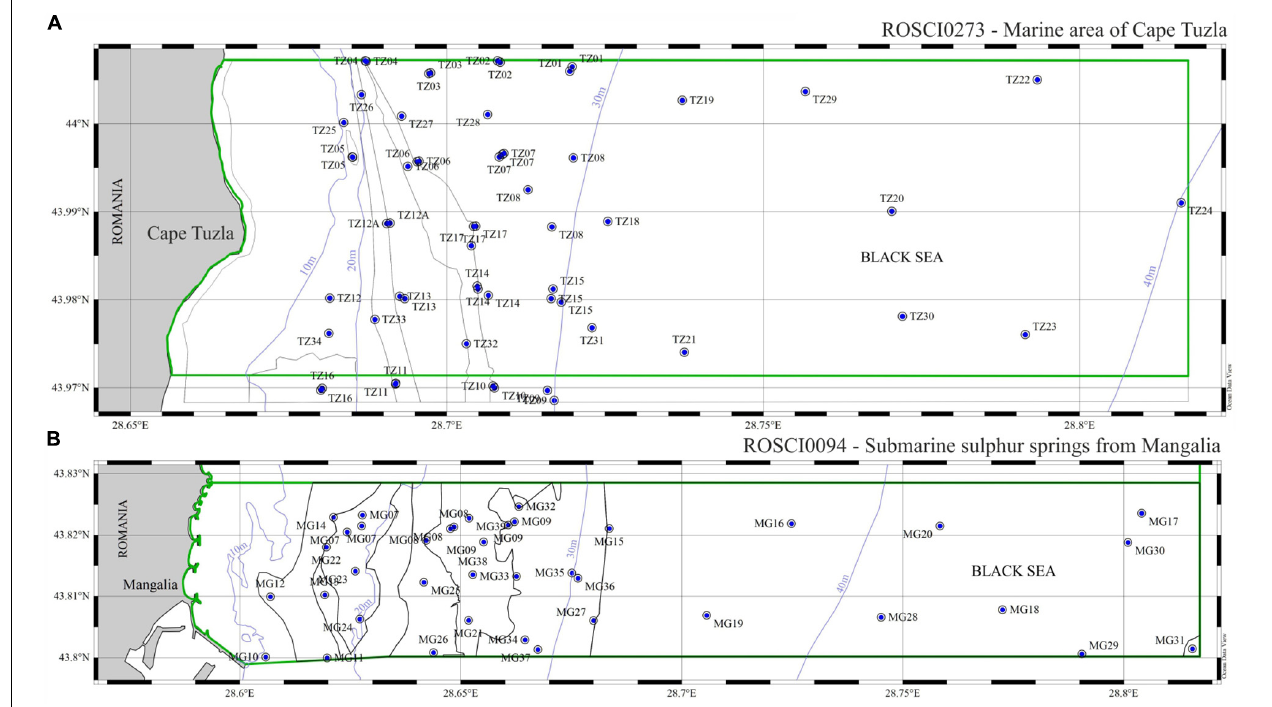
FIGURE 2 | Maps outlining the position of the 47 samples collected in the Cape Tuzla MPA (A) and 28 in the Mangalia Sulfur spring MPA (B) , between 2012 and 2018.